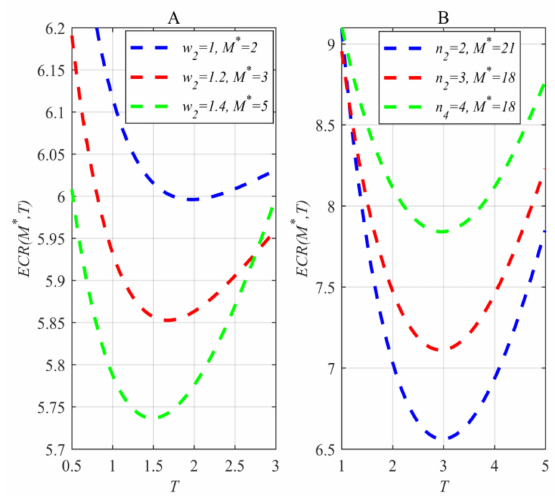
Figure 6. The effect of n 2 and w 2 on the optimal RHPR.